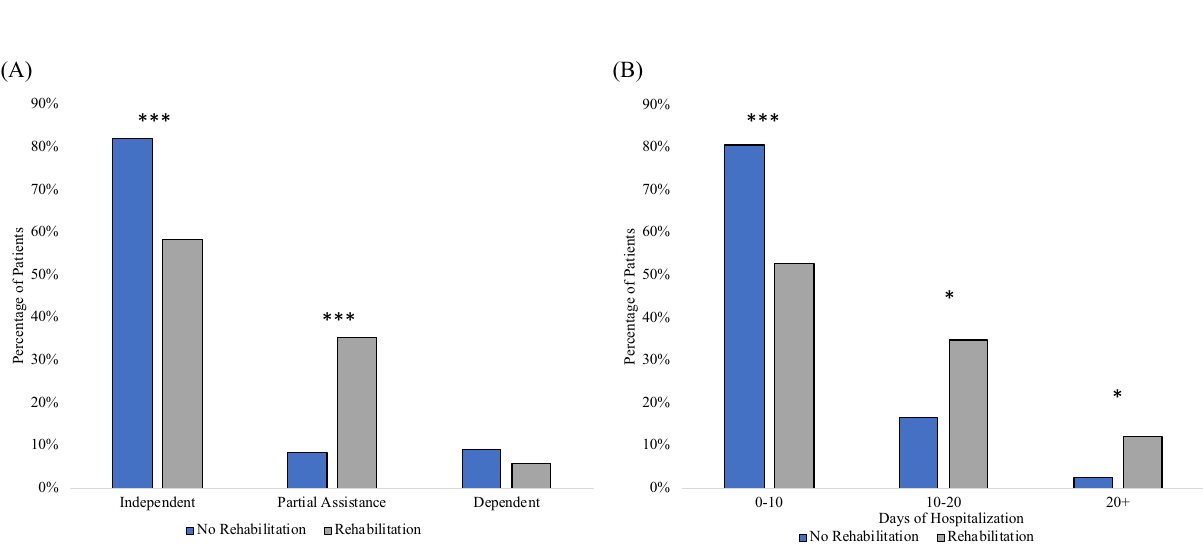
Figure 1. ( A ) Percentage of patients who were independent, dependent, or required partial assistance in the non-rehabilitation (N = 162) group and the rehabilitation (N = 155) group. ( B ) Percentage of patients in the non-rehabilitation (N = 162) and rehabilitation (N = 155) group as a function of lengths of stay. *** indicates significance p < 0.001, * indicates p < 0.05 (Chi square). Note that the percentages sum up to 100% for non- rehabilitation group and 100% for the rehabilitation group,